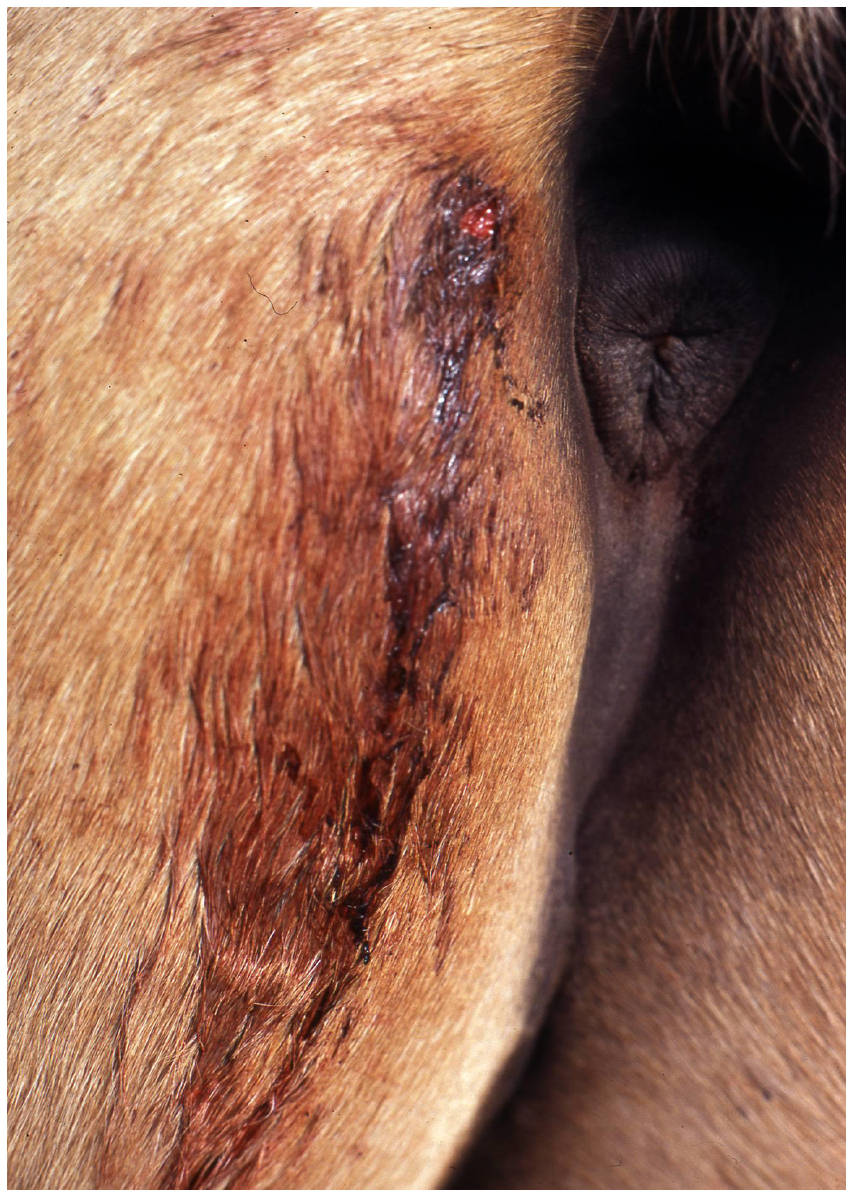
Figure 3. Residual hemorrhage in a horse. Blood continues to flow from the bite after the vampire bat finishes feeding due to the residual effect of its salivary anticoagulants. Vampire bats are the primary reservoir of the rabies virus in tropical and subtropical areas of the Americas. Annually, “paralytic rabies” kills tens of thousands of livestock, dozens of humans and an indeterminate quantity of wildlife [4–6,26–32]. Additionally,